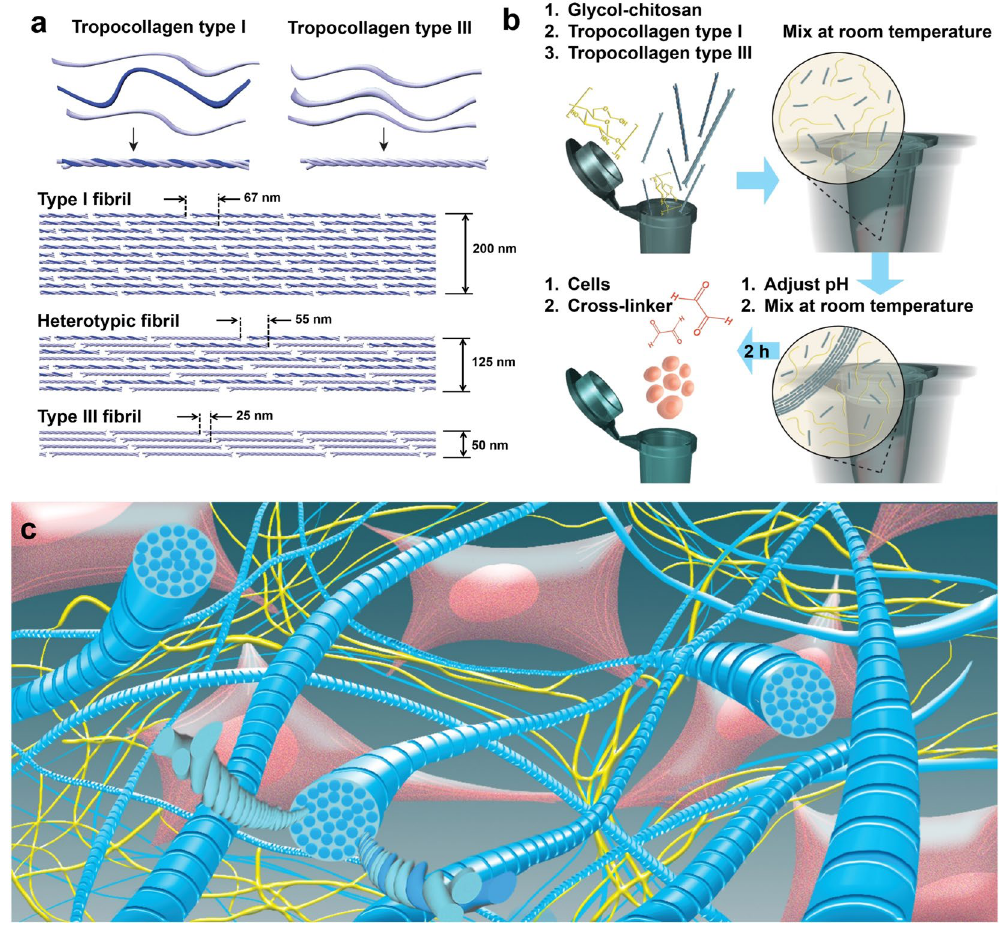
Figure 1. ( a ) Schematic of tropocollagen types I and III followed by their arrangements to form type I fibrils, heterotypic fibrils of types I and III (I&III), and type III fibrils. These illustrations are further supported by data reported in a recent study, in which average (fibril diameter, periodicity) of (200,67), (125,55) and (50,25) were obtained for types I, I&III with a mixing ratio of 1:1, and III fibrils, respectively 23 ; ( b ) Schematic of the step-by-step fabrication procedure. Tropocollagen types I and III molecules were added to glycol-chitosan (GCS) solution, and the mixture was vortexed at room temperature. After adjusting pH to the physiological pH level, the mixture was vortexed again. At this stage, the mixture includes both tropocollagen molecules and newly-formed collagen fibrils. After 2 hours, cells were added and properly mixed. Finally, the cross-linker (glyoxal) was added, and the mixture was mixed to ensure a homogenous cell distribution; ( c ) Schematic of the three-dimensional structure of the nano-fibrillar hybrid hydrogel (Col-I&III/GCS). Heterotypic collagen fibrils (shown in blue) were randomly distributed in GCS matrix (shown in yellow). Heads of the tropocollagen molecules are shown on the cross-sections of the representative fibrils. Glyoxal was used to form covalent cross- linking between GCS molecules as well as between collagen fibrils and GCS matrix. The proposed hydrogel supports cell adhesion because of cell attachments to collagen fibrils, as illustrated (Col-I&III: the simultaneous presence of Col-I and